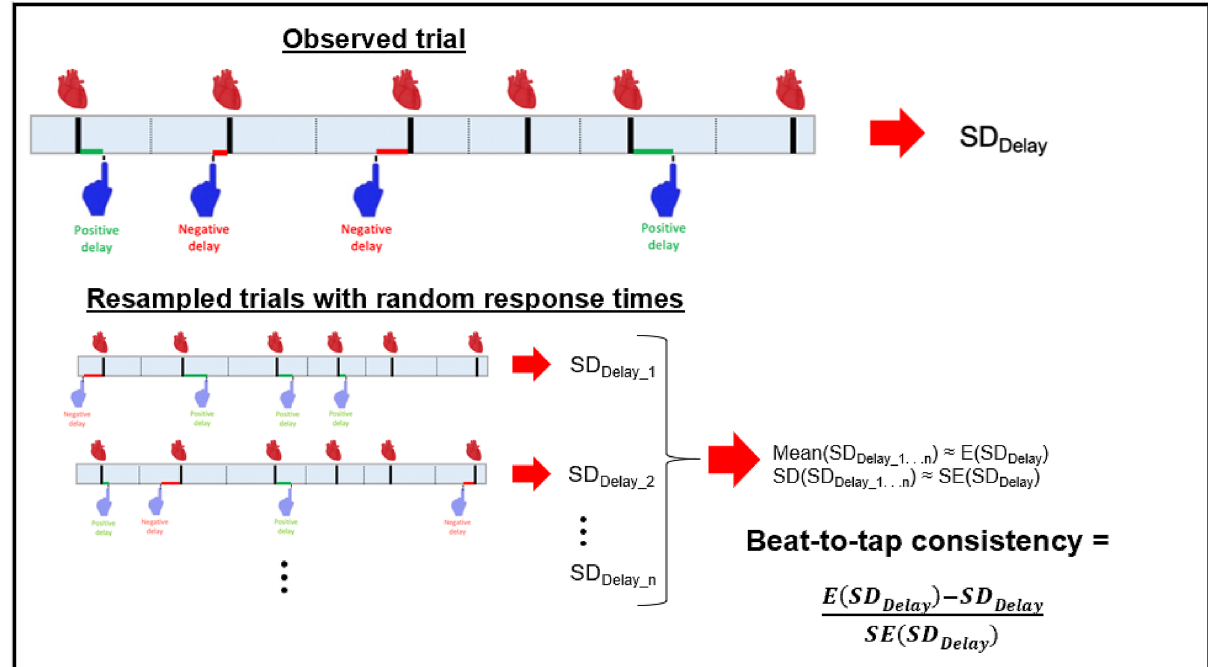
Figure 1. Illustration of how beat-to-tap consistency was calculated as a measure of reliability in the temporal relationship between participants’ heartbeats (shown as thick black lines with heart images above them) and taps (shown as blue hands, with either positive or negative temporal distances from each heartbeat) that was uncorrelated with their heart rate. This involved first estimating the distribution of expected (standard deviation; SD) values under random tapping using a participant’s actual recorded heartbeats and actual number of responses, placed randomly (indicated below by partially transparent hand images) using a uniform distribution for the trial over large numbers of simulated trials (here n = 1000 trials). Then a participant’s actual tapping behavior was converted into a Z-score by subtracting it from the mean and dividing by the standard deviation of the estimated distribution (see main text for more